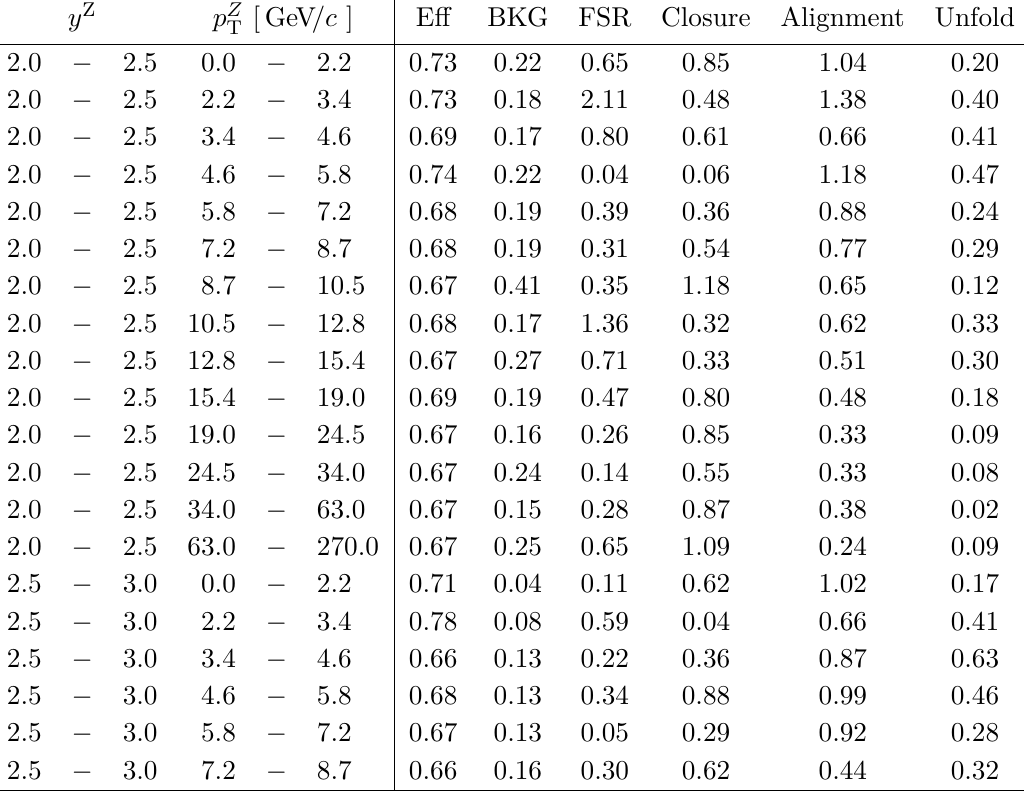
Table 21 . Systematic uncertainties in the single differential cross-sections in interval regions of φ ∗ presented in percentage. The contributions from efficiency (Eff), background (BKG), final state radiation (FSR), closure test (Closure), and alignment and calibration (Alignment) are